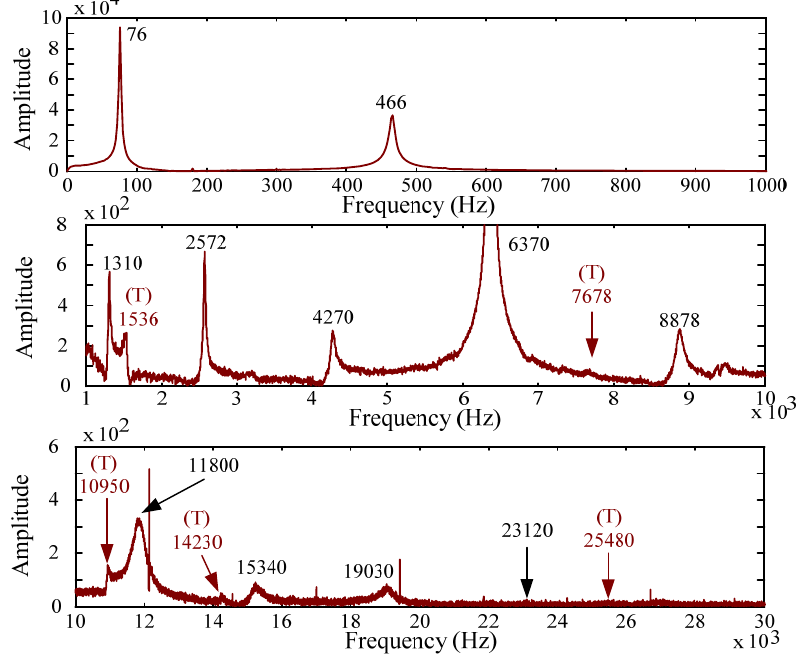
Figure 20. Frequency spectrum of PVDF 20 × 10 with impact on location